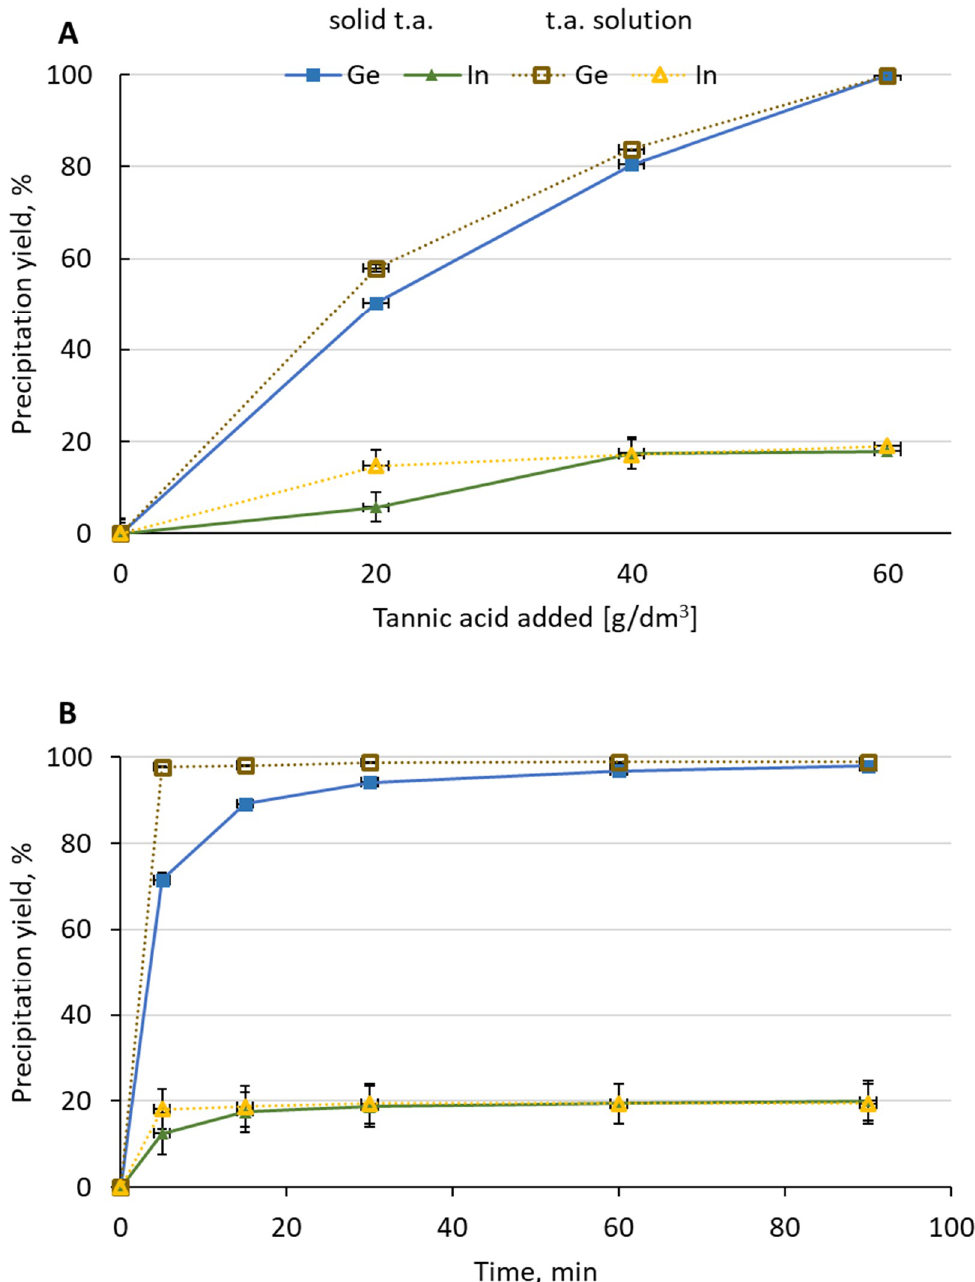
Figure 2. Influence of ( A ) tannic acid added in powder form and as 20% solution and ( B ) time on the precipitation yield of Ge and In from detinned solution ((A)—90 ◦ C, tannic acid added in portions, 1 h precipitation yield of Ge and In from detinned solution ((A)—90 °C, tannic acid added in portions, 1 between portions; (B)—90 ◦ C, 60 g/dm 3 tannic acid added in 1 h between portions; (B)—90 °C, 60 g/dm 3 tannic acid added in 1 portion).